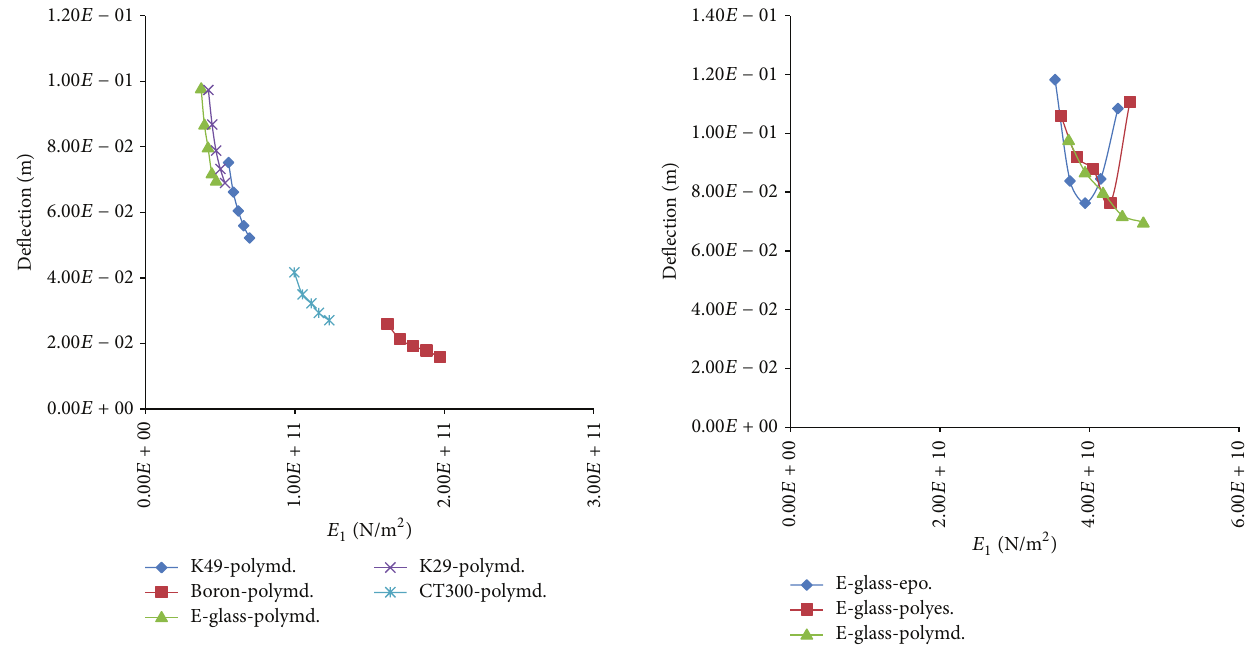
Figure 14: Effect of longitudinal modulus of elasticity on leaf spring deflection of various composite leaf springs based on fiber type.